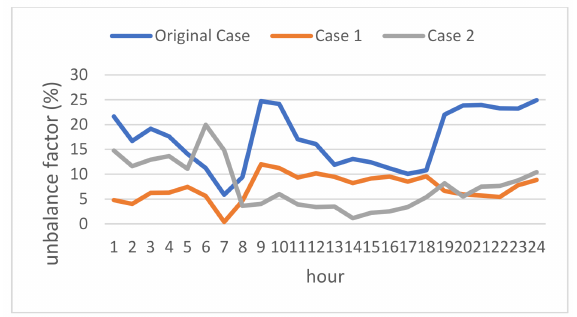
Figure 9. The daily system unbalance factor at the terminal bus.